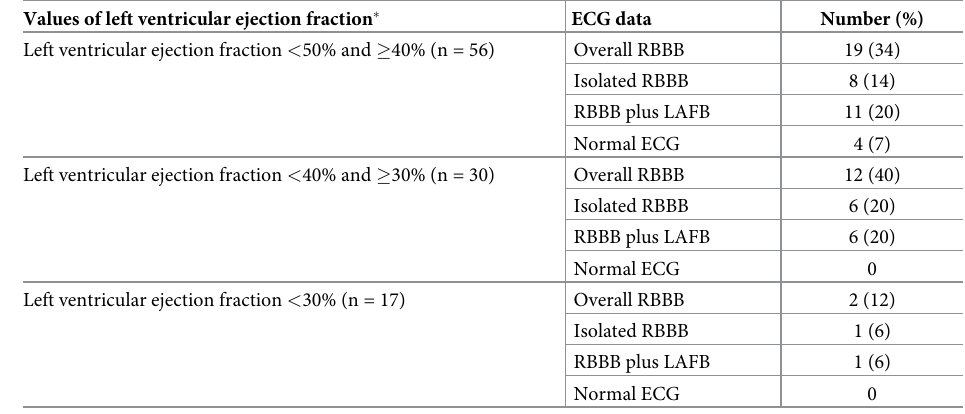
Table 4 lists the sensitivity, specificity, negative and positive predictive values, and accuracy for the parameters analyzed between FoCUS and standard echocardiography. The study shows